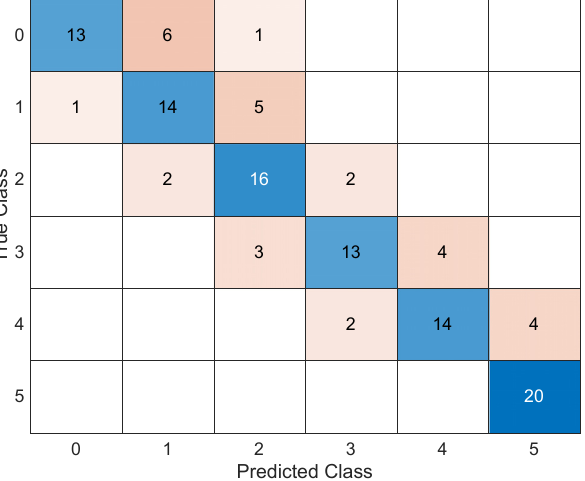
Figure 11. Confusion matrix of AI trained with the penalty matrix.